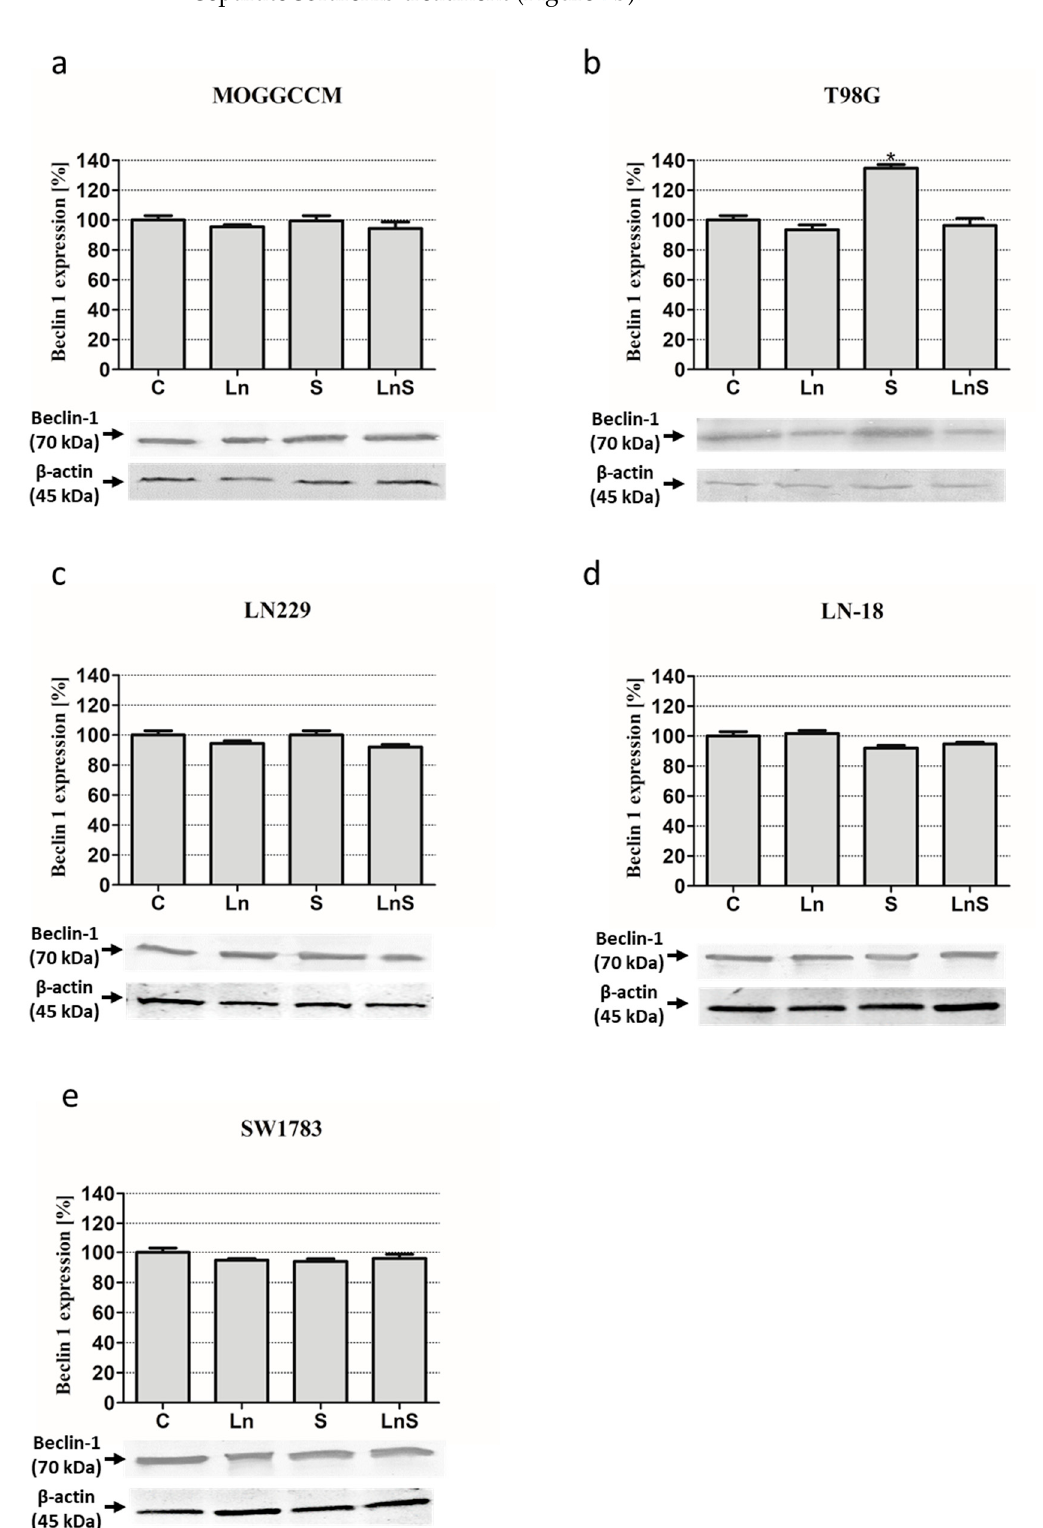
Figure 7. Level of beclin 1 with representative blots in MOGGCCM ( a ), T98G ( b ), LN229 ( c ), LN-18 ( d ), and SW1783 ( e ) cells after treatment with lensoside A β (L) and sorafenib (S) applied alone or in combination (LS). C—control; * p < 0.01 compared to the control.